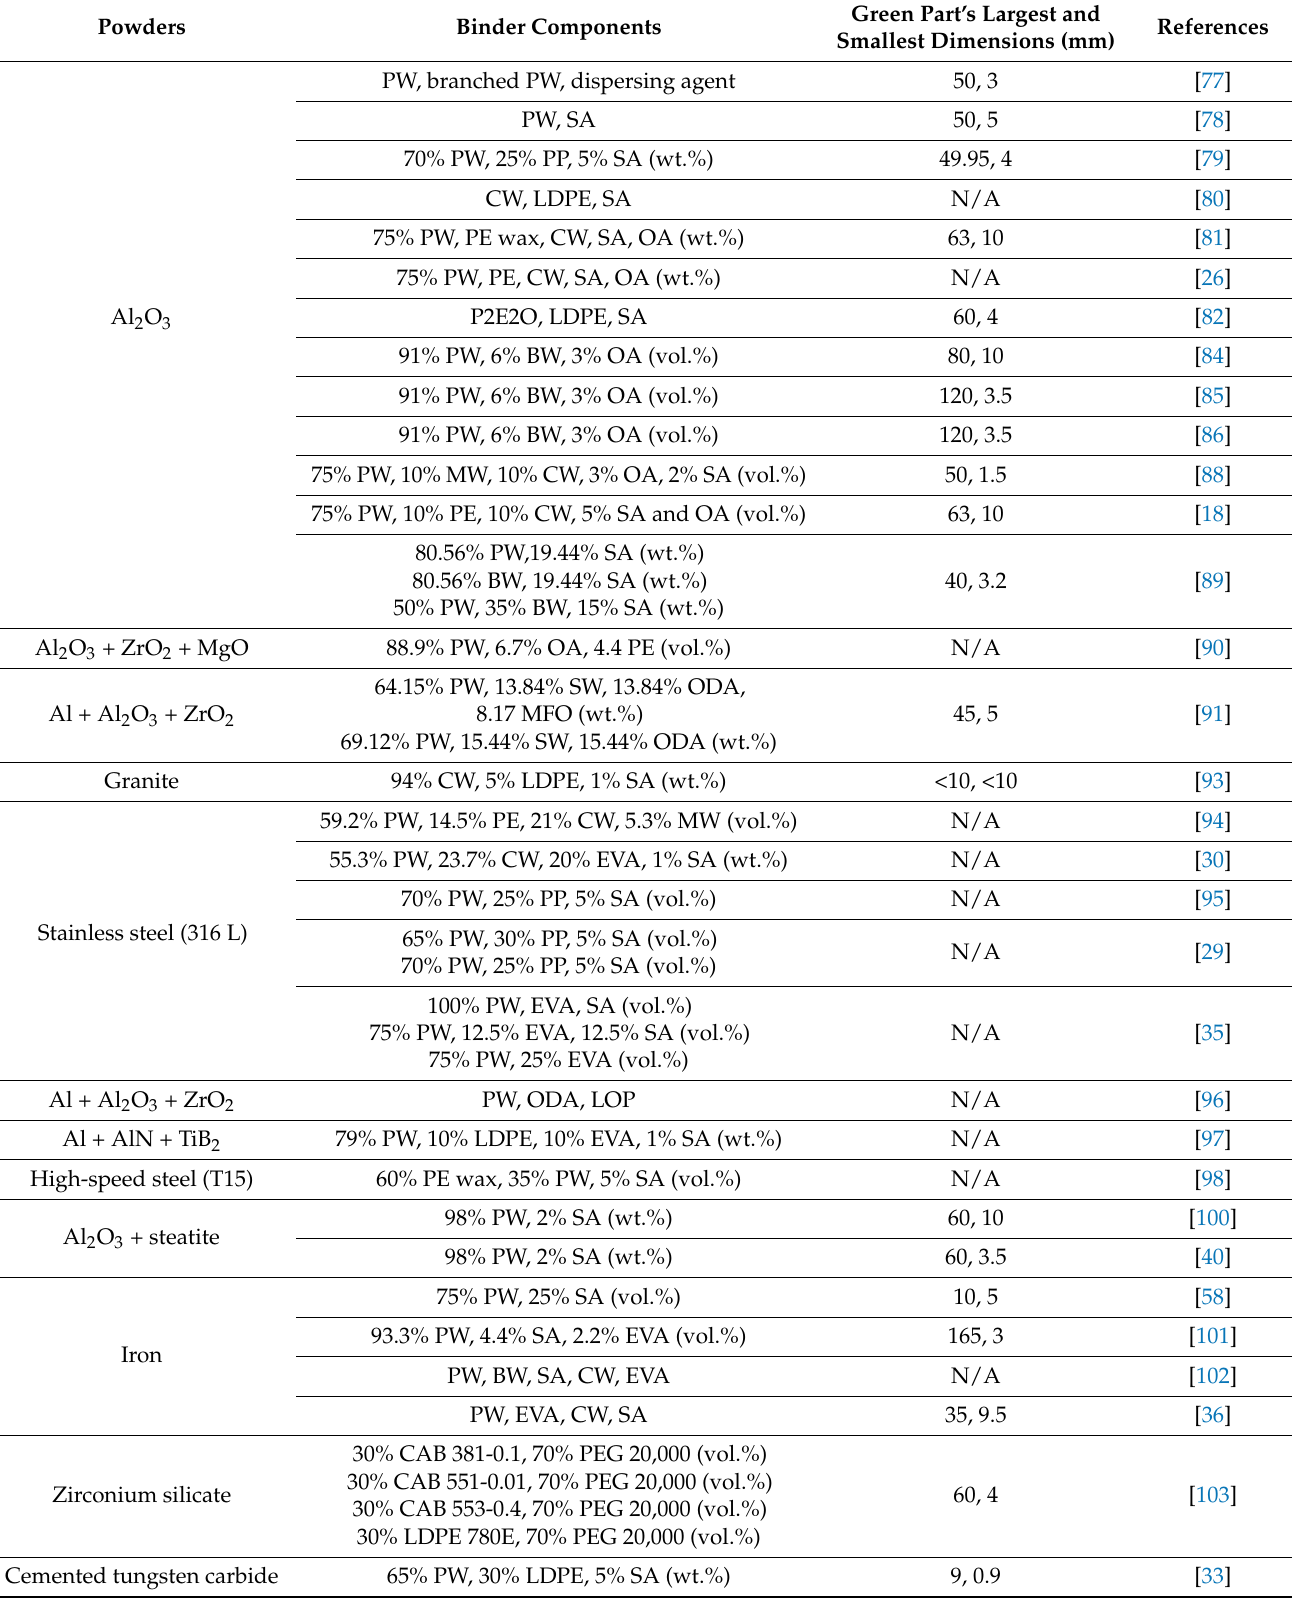
Table 2. Current examples of binder systems and their respective powders used in the LPIM